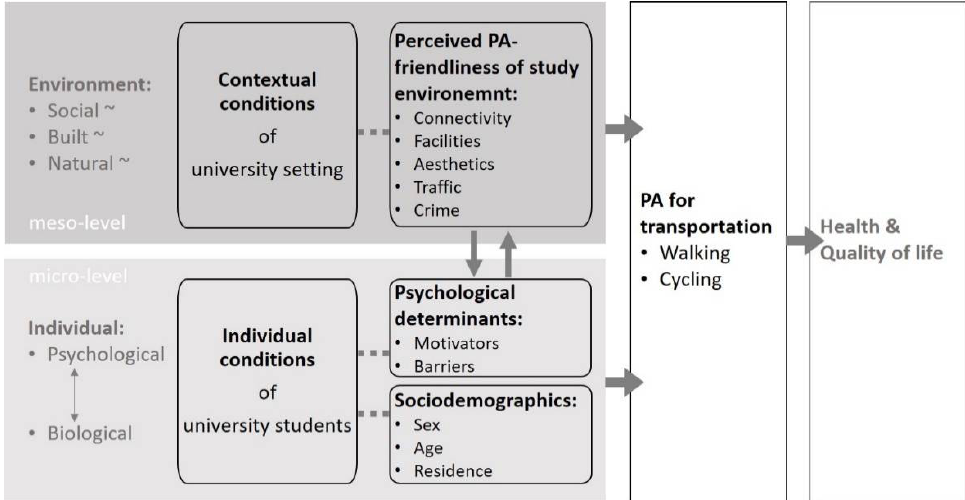
Figure 1. Schematic representation of the socio-ecological approach of PA promotion adapted to the university setting (own presentation based on Bucksch et al. (2012) [13] and Bauman et al. (2012) [12] ).